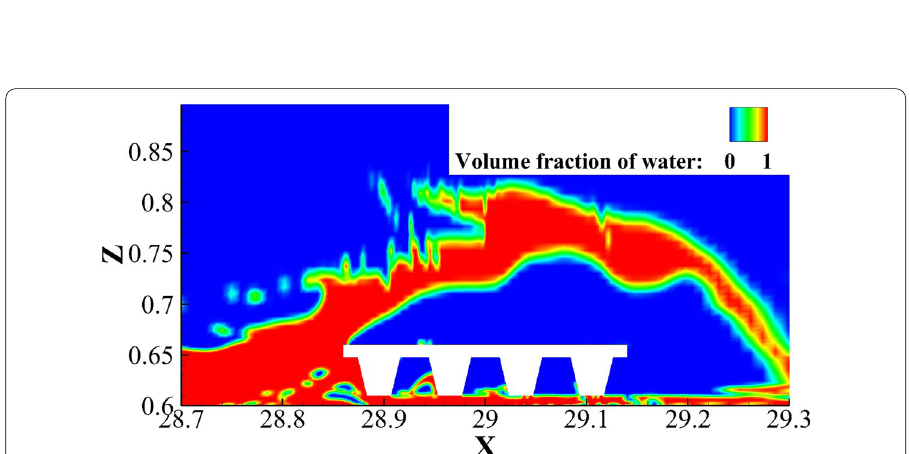
Fig. 23 Phase contour at t (units of axes: